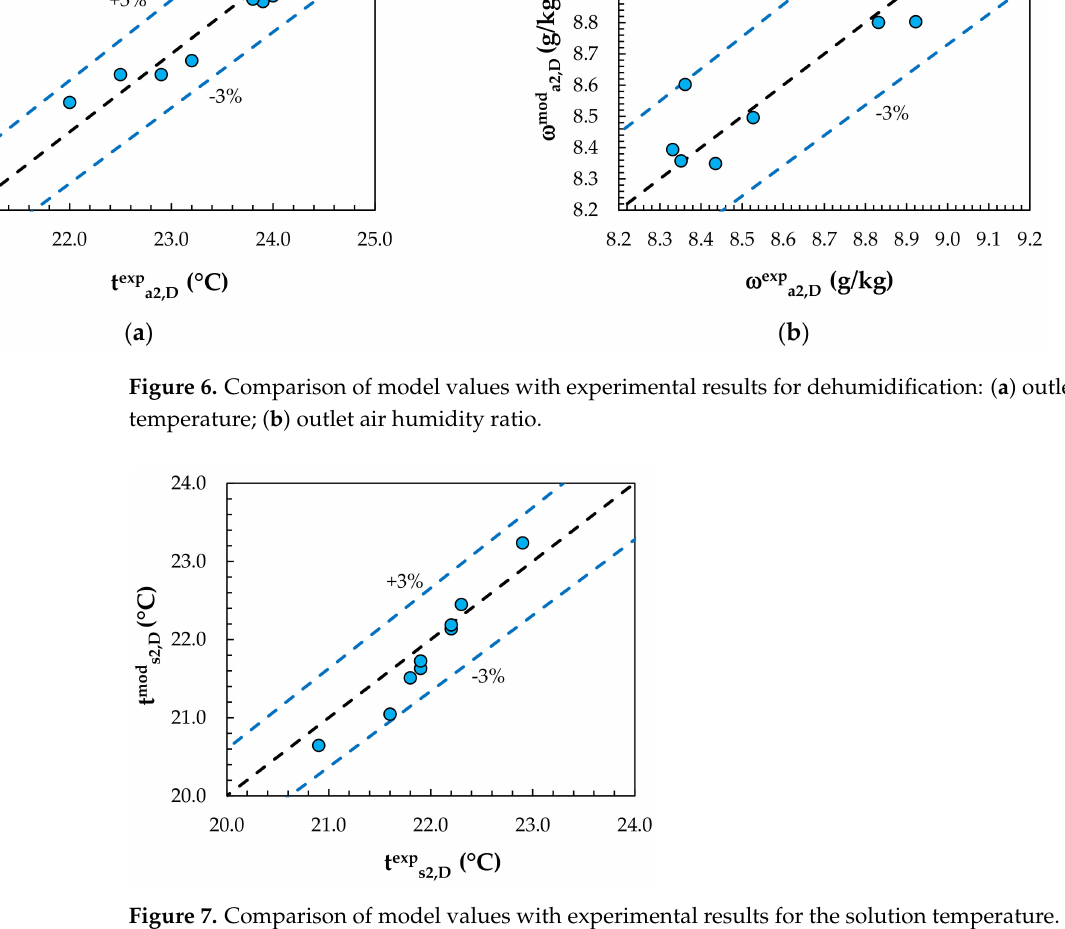
Figure 7. Comparison of model values with experimental results for the solution